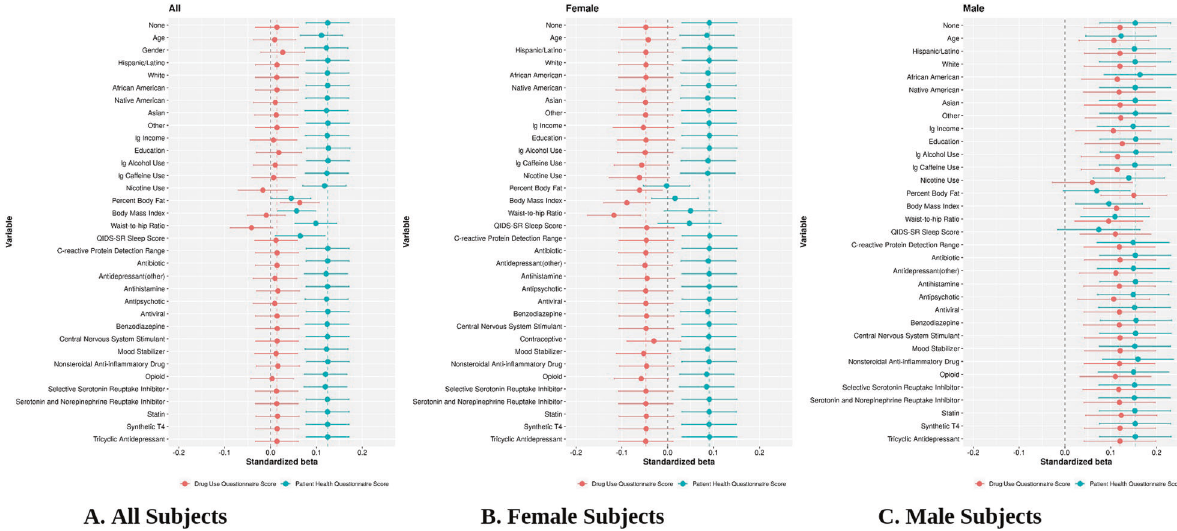
Fig. 4 Standardized beta coef fi cients for confounder effect of variables on association with CRP. Plots show the variables with the largest shifts from baseline with DAST only (pink) or PHQ-9 only (green), indicating a decreased or increased association between CRP and psychiatric symptoms. The labels of the y -axis represent which individual variable is included in the model. Plots for A All; B Female; and C Male subjects. Note that the top line of the fi gure (indicated by None) shows the unadjusted/simple model, and each subsequent line shows the effect of the relevant covariate progressively added on the unadjusted/simple relationship. Initially for the All sample (Fig. 4A), PHQ-9 is signi fi cantly associated with CRP in the unadjusted/simple models (as seen by the right shift from baseline of 0), while DAST is not (the error bar crosses the baseline of 0). For PHQ-9, PBF, BMI, and WHR all shift the association to the left, thereby decreasing the beta values for this association. On the other hand, for DAST, PBF shifts the association to the right (increases) while BMI and WHR decrease the beta values for this association, showing opposite effects. For the female-only sample in the unadjusted/simple model, PHQ-9, but not DAST, is signi fi cantly associated with CRP (Fig. 4B). Here, PBF, BMI, and WHR decrease these beta values. For the male-only sample (Fig. 4C), both DAST and PHQ-9 are signi fi cantly associated with CRP in the unadjusted/simple model, and like the females, PBF, BMI, and WHR decrease this association for PHQ-9. Interestingly, BMI and WHR decrease this association for DAST, while PBF increases this association in